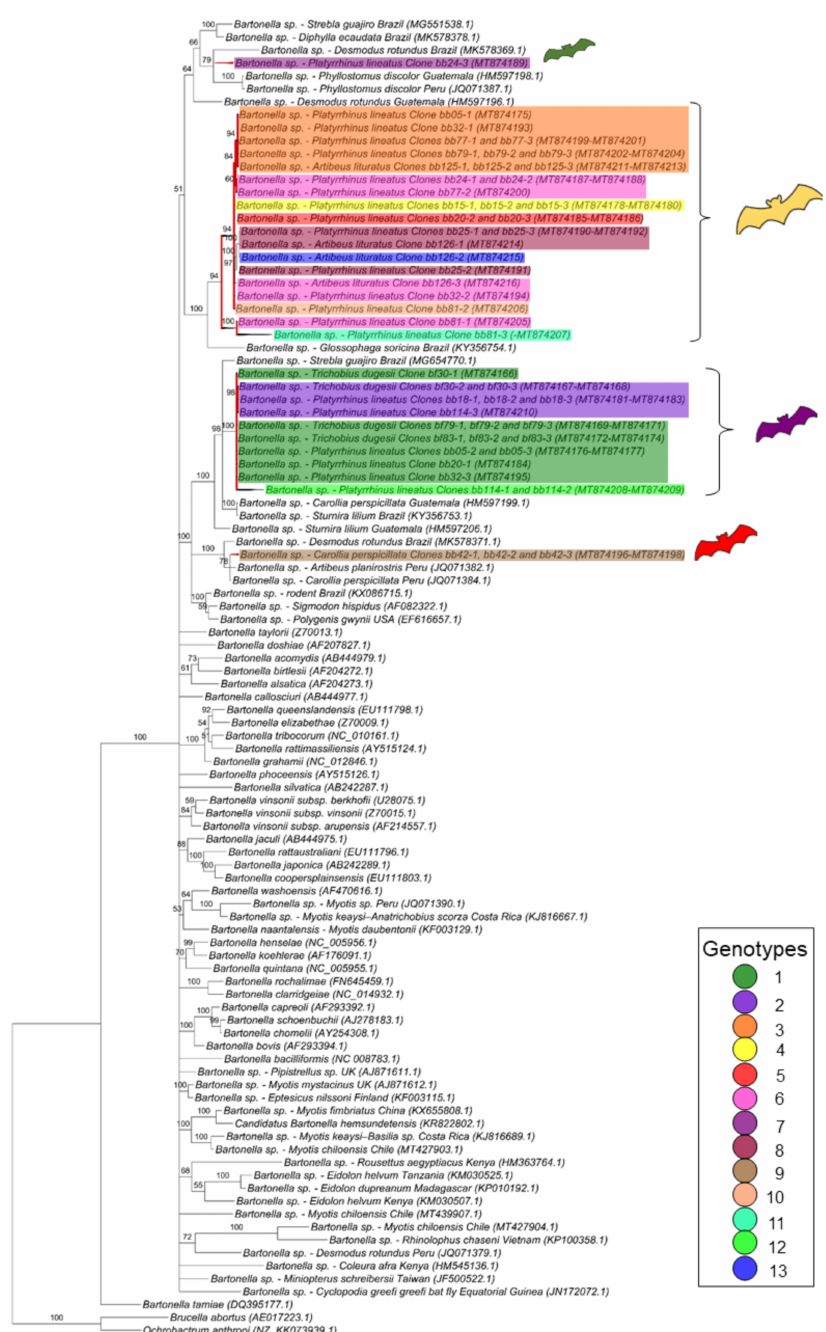
Figure 2. Phylogenetic tree based on an alignment of 790 bp-length of Bartonella spp. gltA sequences, using the Bayesian Inference method and TVM + I + G as the evolutionary model. Numbers at nodes correspond to the posterior probability value support. Each sequence-clone or group of sequences-clone are highlighted according to their respective genotype. The colored bats are positioned according to the groups found in the genealogy network. Each sample is designated with the type of sample (bb = bat blood and bf = bat fly) followed by the referred animal and clone